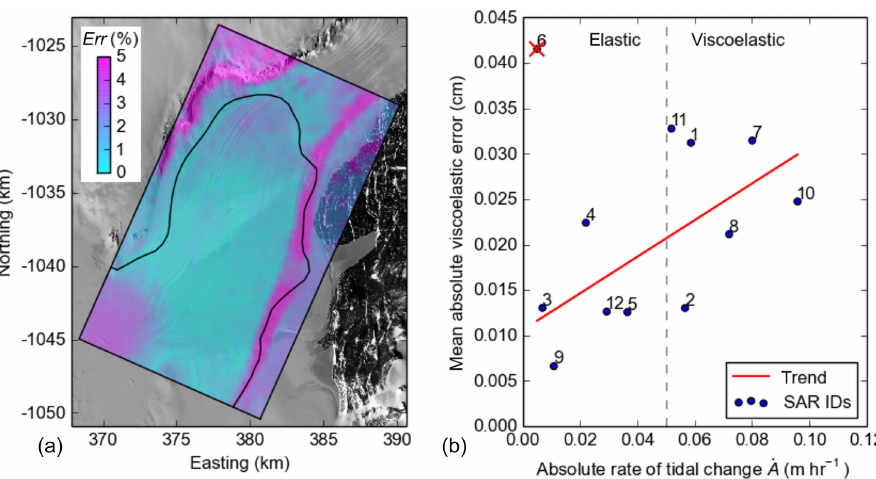
Figure 13. Map of average error due to viscoelasticity in percentage of tidal amplitude (a) and average error on the floating part of the Darwin Glacier versus rate of tidal change as predicted with the adjusted Ross_Inv_2002 tide model (b) . Image 6 is considered an outlier and was excluded from the calculation of the linear